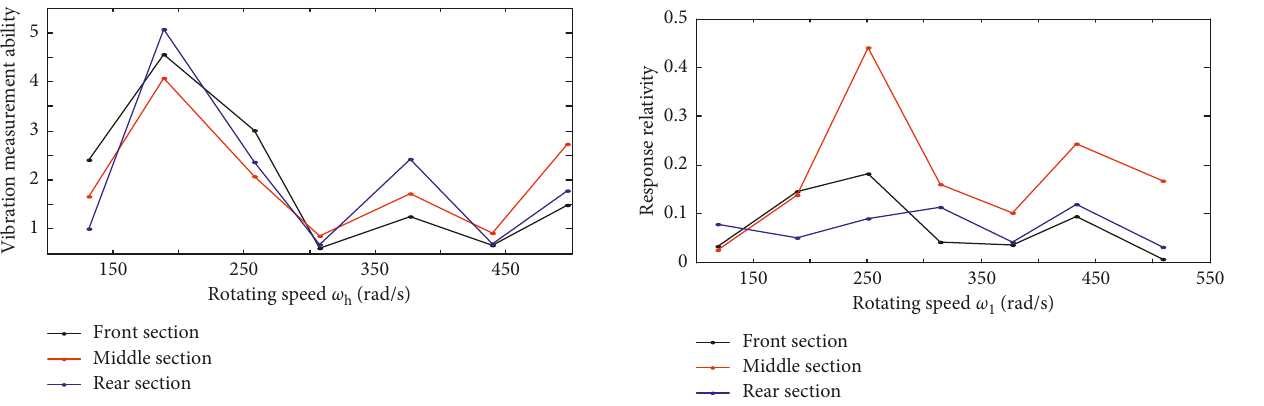
Figure 20: Experimental vibration measurement ability C with varying rotating speed of high-pressure rotor ω h : front section (black), middle section (red), and rear section (blue).